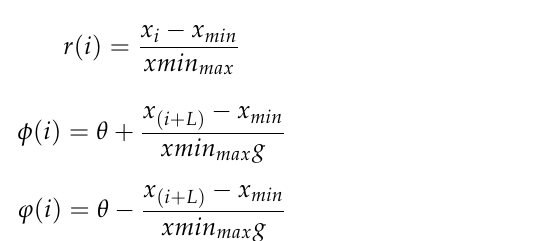
Figure 1. Schematic diagram of the SDP approach.